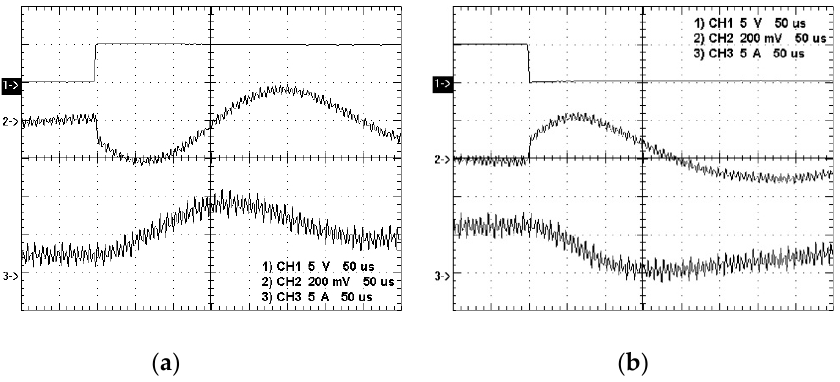
Figure 15. Waveforms based on the proposed PWFM control strategy: (1) load enable; (2) AC output voltage; (3) inductor current, due to ( a ) from 50% to 100%; ( b ) from 100% to 50%.